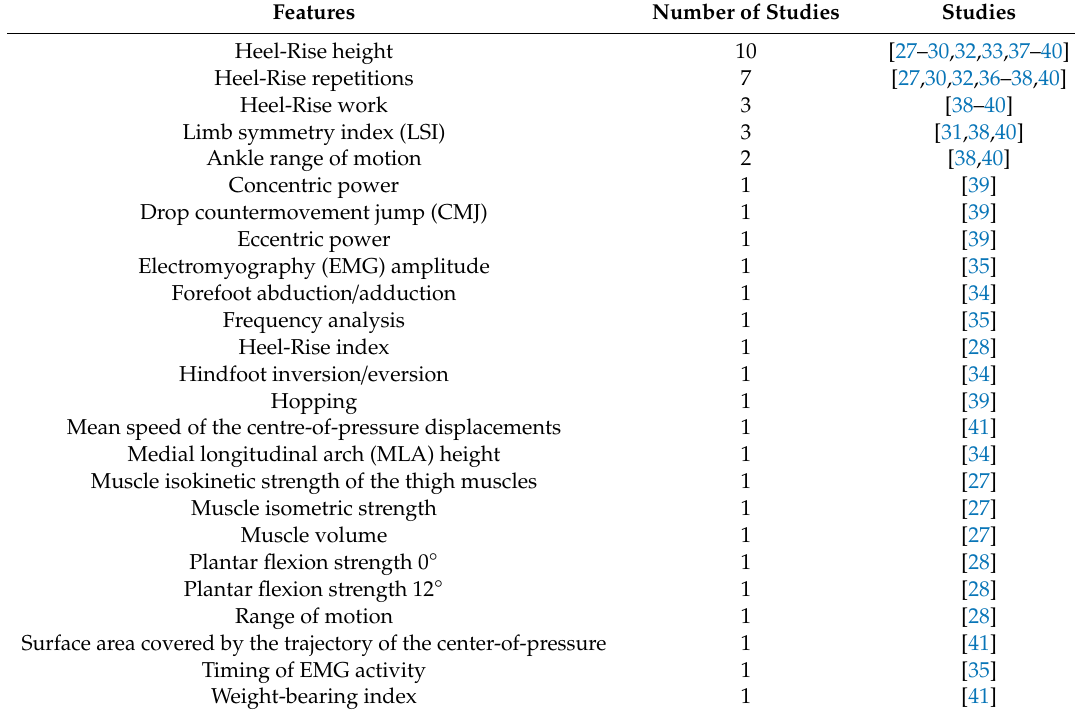
Table 2. Features available in the di ff erent